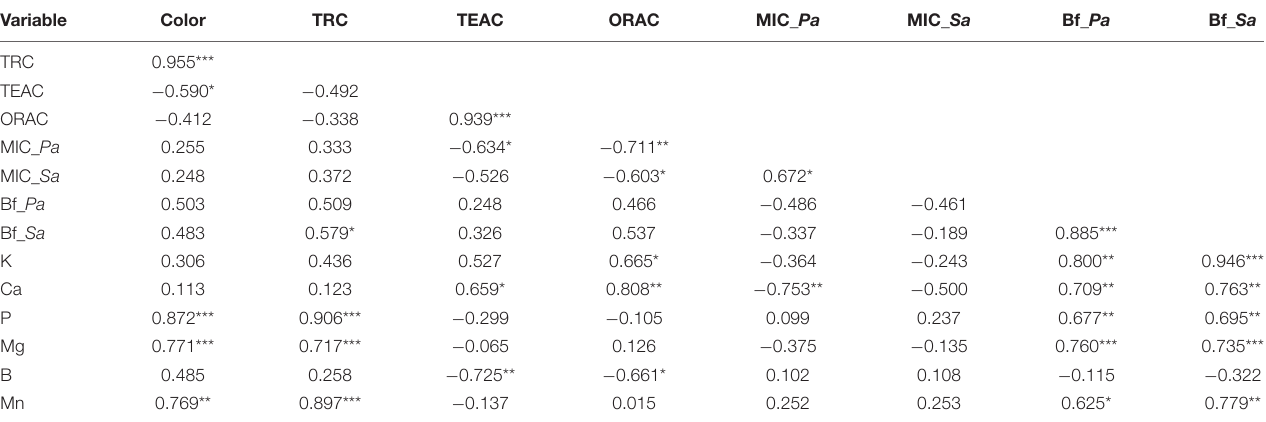
TABLE 7 | Correlation matrix (Pearson’s correlation coefficients) of color, antioxidant, broth microdilution, biofilm degradation and macroelement parameters in Hungarian honeys.